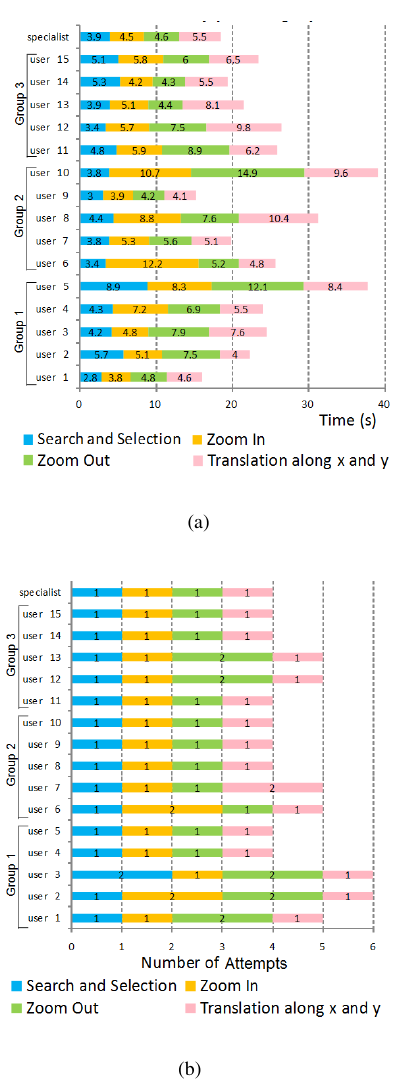
Fig. 14: In (a) and (b), the time spent and number of attempts to perform different tasks, when interacting with 2D images, respectively.